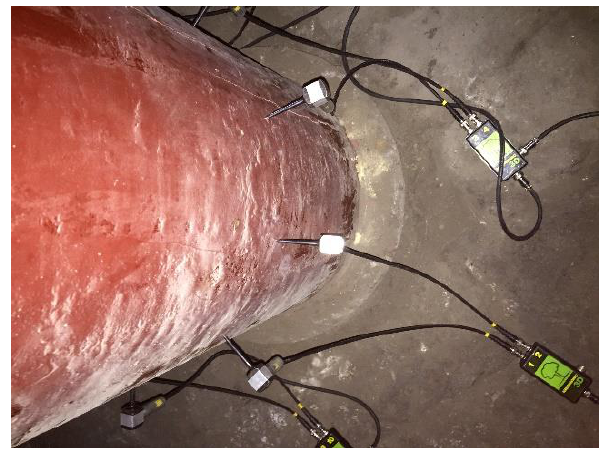
Figure 7 Plan sketch of the main hall